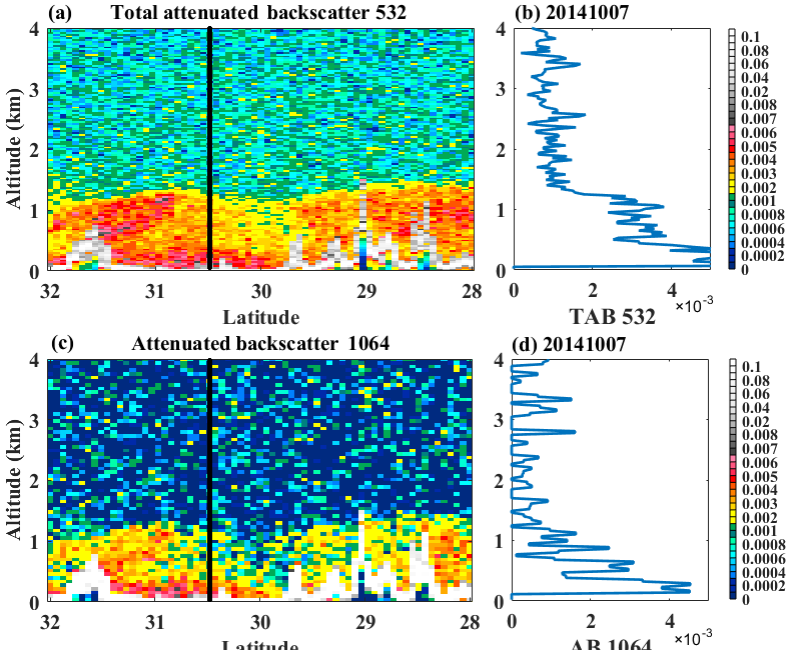
Figure 2. (a) Total attenuated backscatter at 532nm wavelength (TAB 532 ) and (c) the attenuated backscatter at 1064nm wavelength (AB 1064 ) plot from CALIPSO on 7 October 2014. Panels (b) and (c) indicate the corresponding vertical profile of TAB 532 and AB 1064 derived from CALIPSO profile over Wuhan area, respectively. The number of horizontal smoothing is 20.